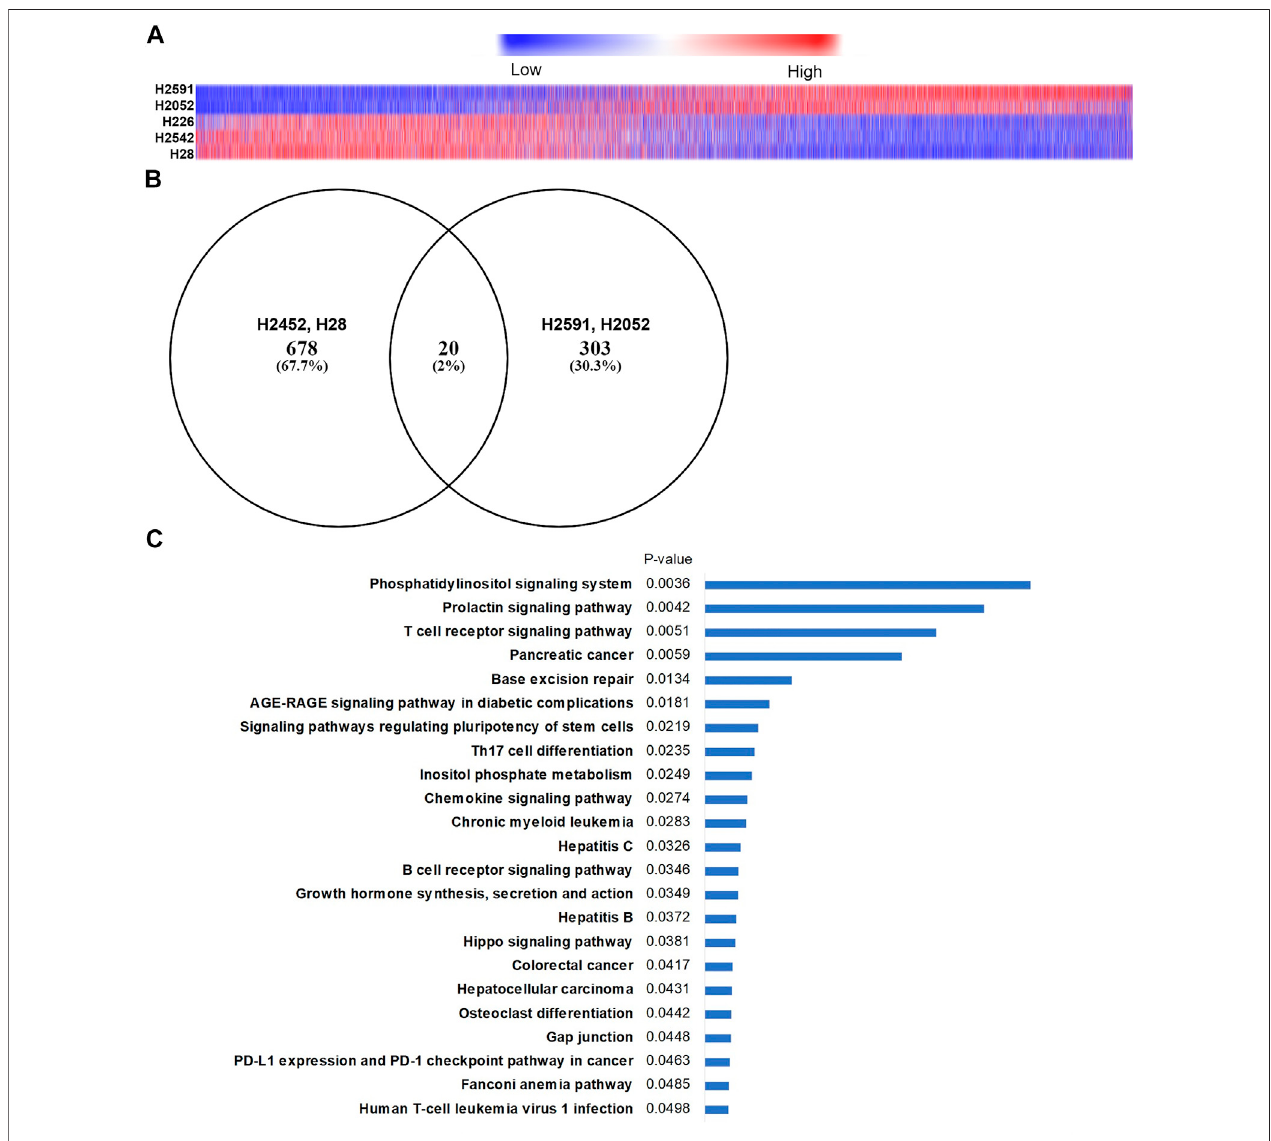
FIGURE 3 | RNA sequencing in mesothelioma cells with and without NF2 mutations. (A) Heatmap of 17,000 genes identi fi ed (has Ensembl annotation, median expression ≠ 0) showing differential expression changes after 6 h quinacrine treatment compared to vehicle. Order is based on H2591 expression changes. Approximately3,000geneshadasigni fi cantlydifferent( p < 0.05)responsefromquinacrinetreatmentwhencomparingH2591/H2052NF2-mutatedcellstoH2542/H28 NF2 WT cells (see Supplementary Figure 6 for pathway comparison); (B) Venn diagram of differential expressed genes for quinacrine-treated cells compared to untreatedcells. (C) Toprelated KEGG2021pathways ofquinacrine-induced geneticexpression changesforH2591 andH2052 compared tovehicle(determinedusing Enrichr).